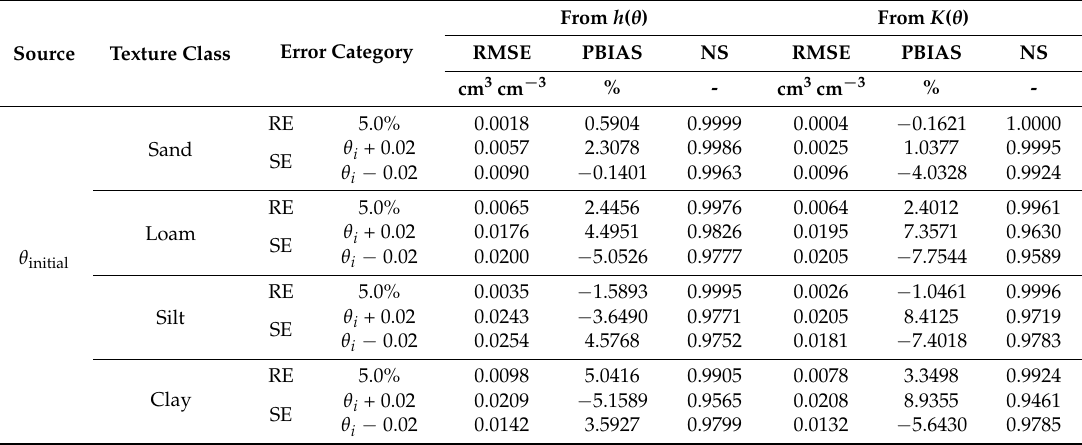
Table 6. Soil water content errors from estimated SWRCs and SWRCs considering both random and system errors on initial and final water content levels for the four typical